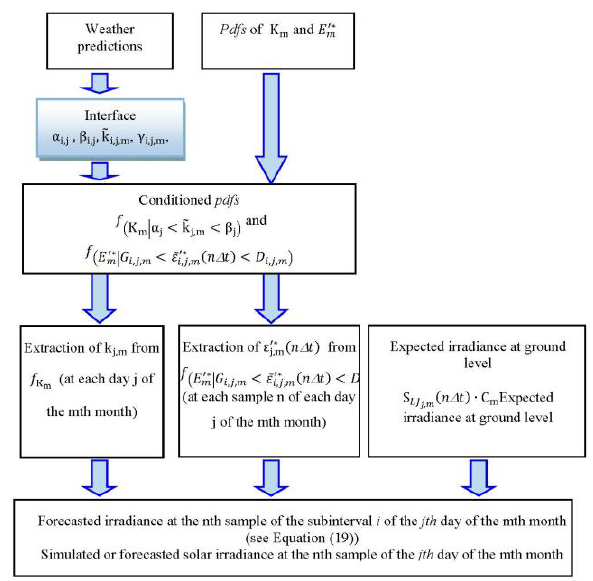
Figure 4. Flow chart of the “Forecasting of solar irradiance including weather predictions” stage.